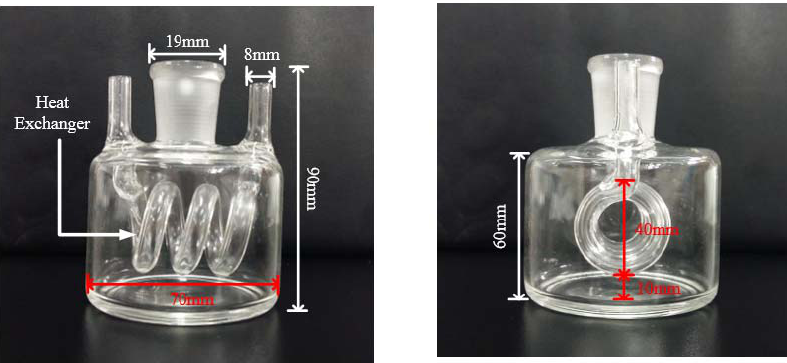
Figure 1. The proposed reactor with a heat ‐ exchanger.